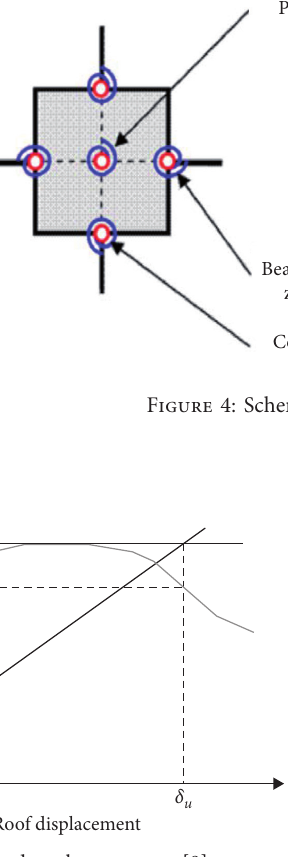
Figure 5: Idealized pushover curve